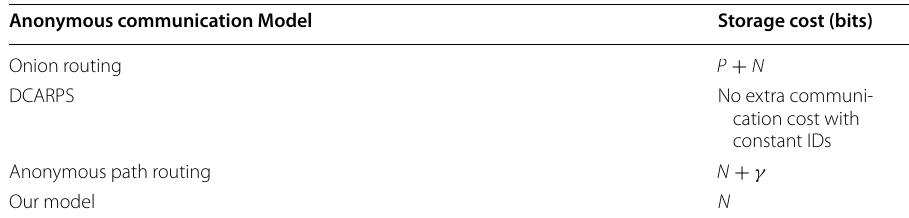
Table 4 Performance comparison on communication